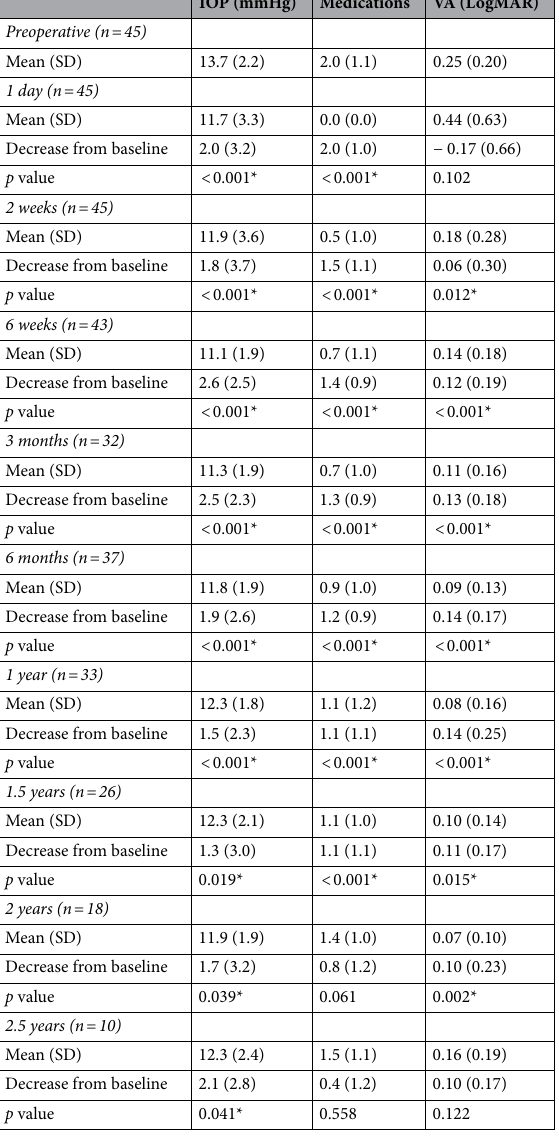
Table 2. Postoperative outcomes data. n = total number of patients at specific follow-up time; SD = standard deviation; IOP = intraocular pressure; mmHg = millimeters of mercury; VA = visual acuity; LogMAR = logarithm of the minimum angle of